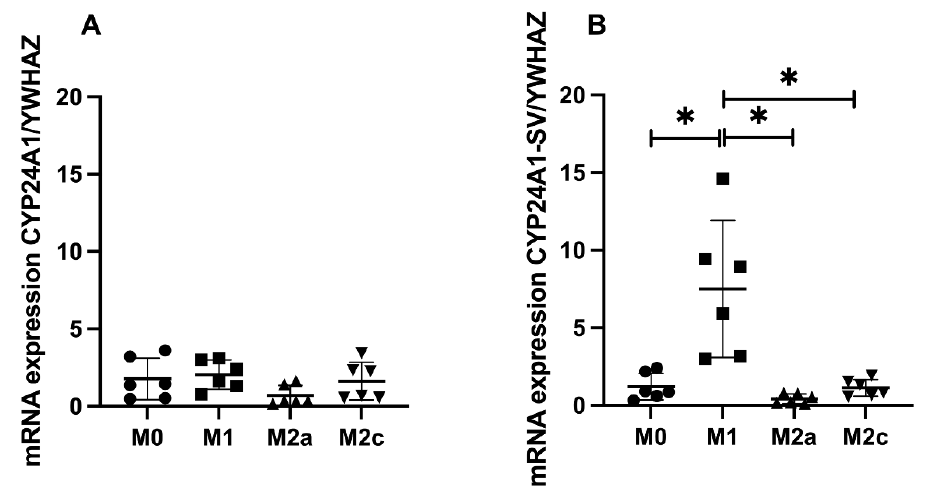
Figure 4. Expression of CYP24A1 and CYP24A1-SV in polarized MDMs after vitamin D stimulation. MDMs were polarized into M0, M1, M2a and M2c MDMs and stimulated with 1000 nM 25-hydroxy- vitamin D for 24 h. The mRNA expression of CYP24A1 is shown in ( A ) and the mRNA expression of its splice variant, CYP24A1 , is shown in ( B ). Both expressions are shown relative to a household gene ( YWHAZ ). * Indicates a statistically significant difference between groups.